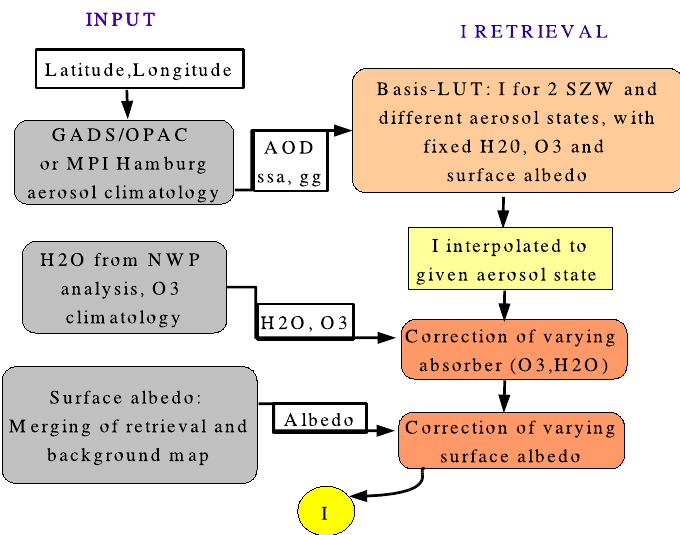
Figure 5. Diagram of the new clear sky LUT. SZW is the solar zenith angle. NWP is Numerical Weather Prediction, I is the solar surface irradiance. This procedure is applied for each wavelength band. Figure has been previously published in